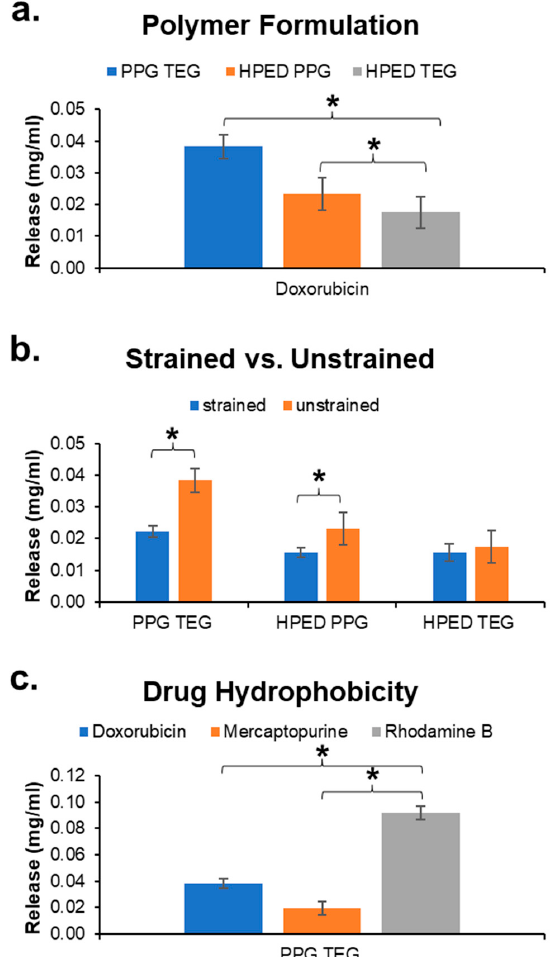
Figure 5. Drug release is based on the physical and chemical properties of polymers and drugs. ( a ) Effect of polymer formulation, ( b ) effect of straining/fixing samples in secondary shapes, and ( c ) effect of drug hydrophobicity. Mean ± standard deviation displayed. n = 3. * p < 0.05 between formulations under brackets.